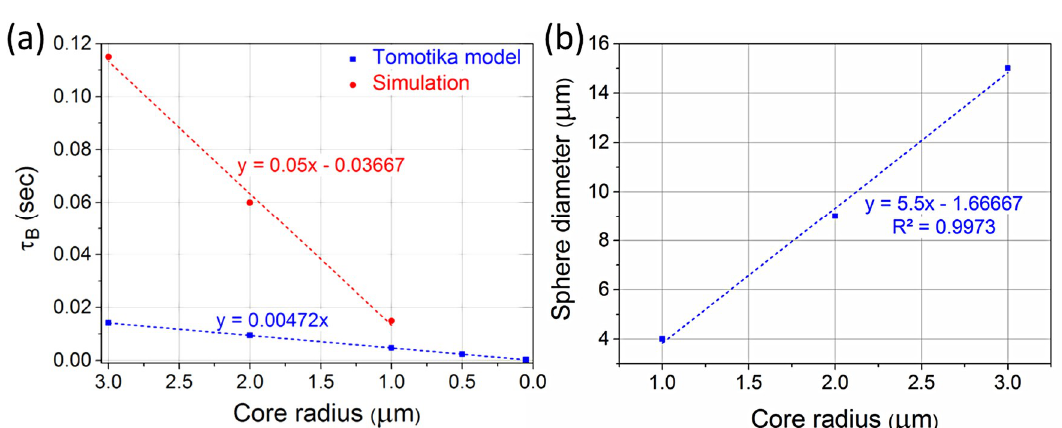
Figure 6. ( a ) Breakup time as a function of the initial core radius at T = 1200 °C calculated using simulations (red) and the Tomotika model (blue). ( b ) Sphere diameter as a function of the core radius at T = 1200 °C.